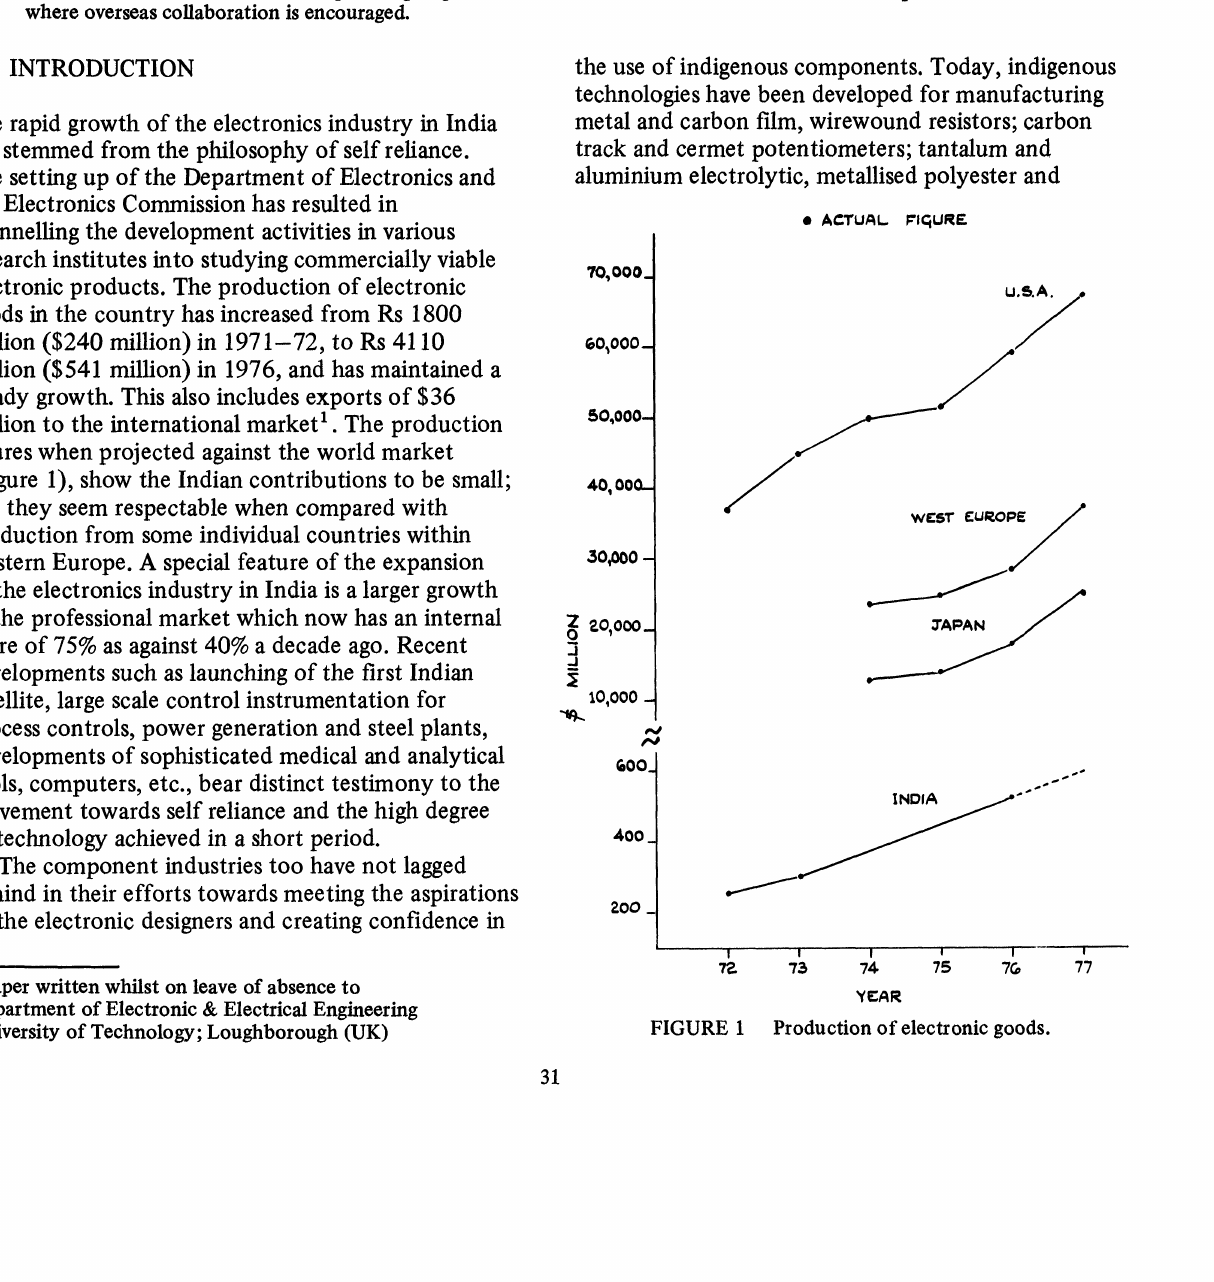
YEAR FIGURE Production of electronic